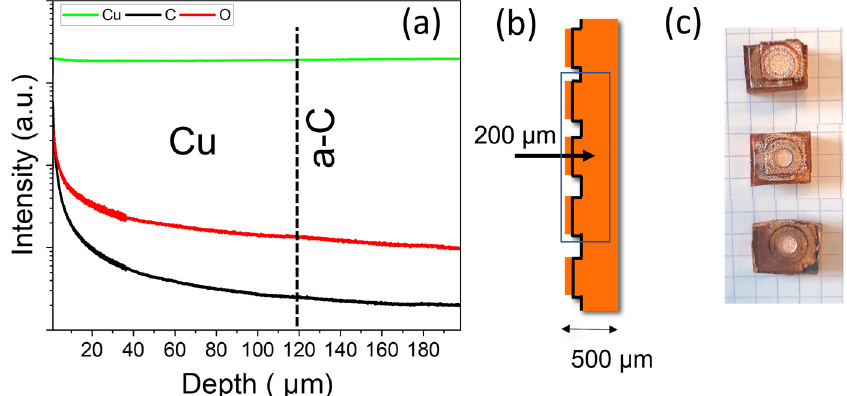
Figure 10. ( a ) GDOES depth analysis presenting the signals of Cu, C, and O emission lines up to 200 µm below the external surface of the sample. ( b ) Schematic representation of the compressed cross-section of the cubes and the building plate. ( c ) Topography of the three analyzed cubes after compression.